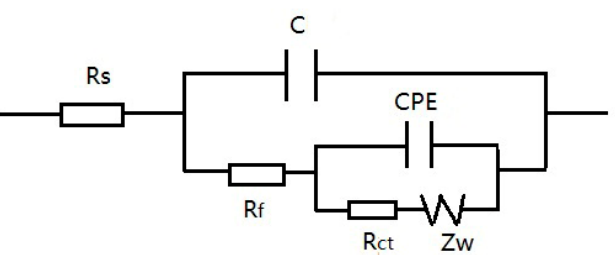
Figure 11. The equivalent circuit of the X70 carbon steel in 0.10 mol / L NaCl solution with Na 3 PO 4 and / or NaNO 2 inhibitor(s). Rs: solution resistance; Rf: film resistance; Rct: charge transfer resistance; C: double layer capacitance; CPE: constant phase element; Zw: Warburg impedance.